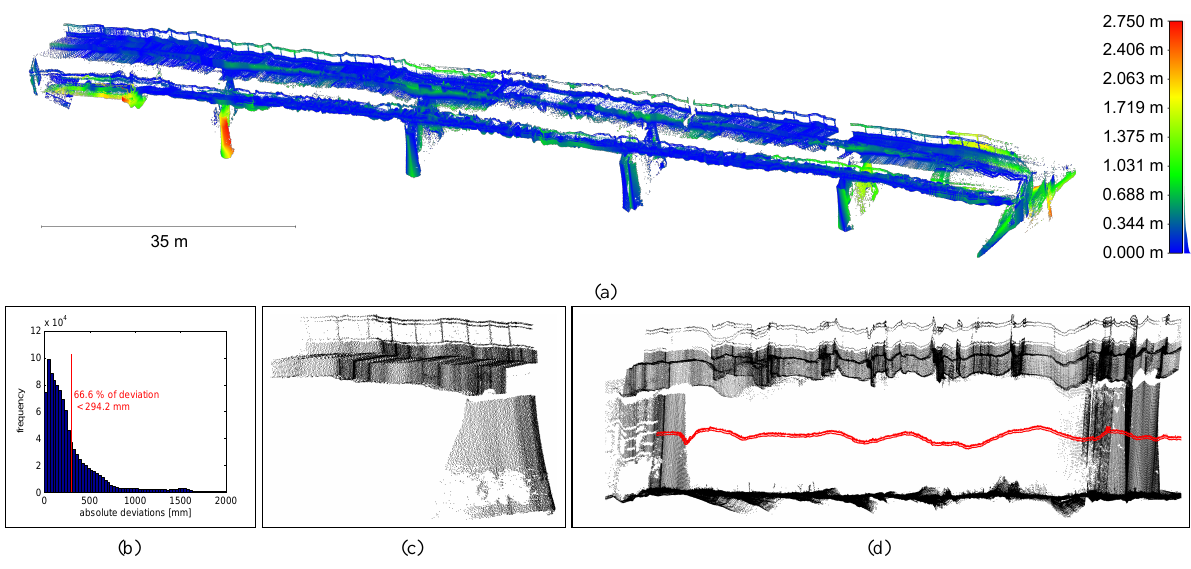
Figure 6: (a) Color-coded absolute distances between LSRF and TLS point clouds obtained by CloudCompare. (b) Histogram of absolute distances. (c) Good represented part of the bridge by LSRF points. (d) Bad represented part of the bridge by LSRF points caused by inaccurate IMU angles in lateral direction. Red points are the flight path of the UAV.